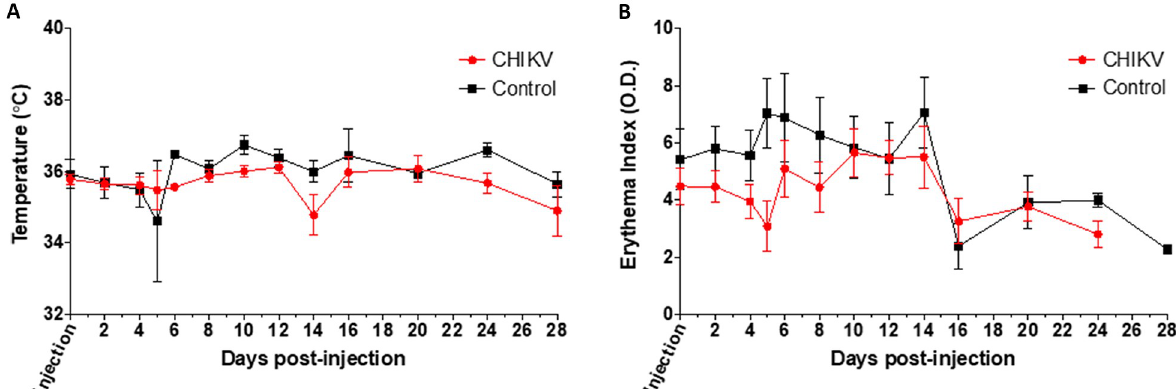
Fig 1. Clinical signs of CHIKV infection in Hu-NSG mice after needle inoculation into the rear footpad. ( A ) Temperature and ( B ) erythema index of CHIKV-injected mice as compared to control mice injected with saline were assessed as a measure of disease up to 22 days post-infection. CHIKV-injected mouse data are shown in red, while uninfected control mice data are indicated in black. Unpaired t-tests were used to determine statistical significance between CHIKV-injected and uninfected mice at each time point; however, no significant differences were seen when comparing CHIKV-injected mice with saline-injected mice. Mice per group: n �